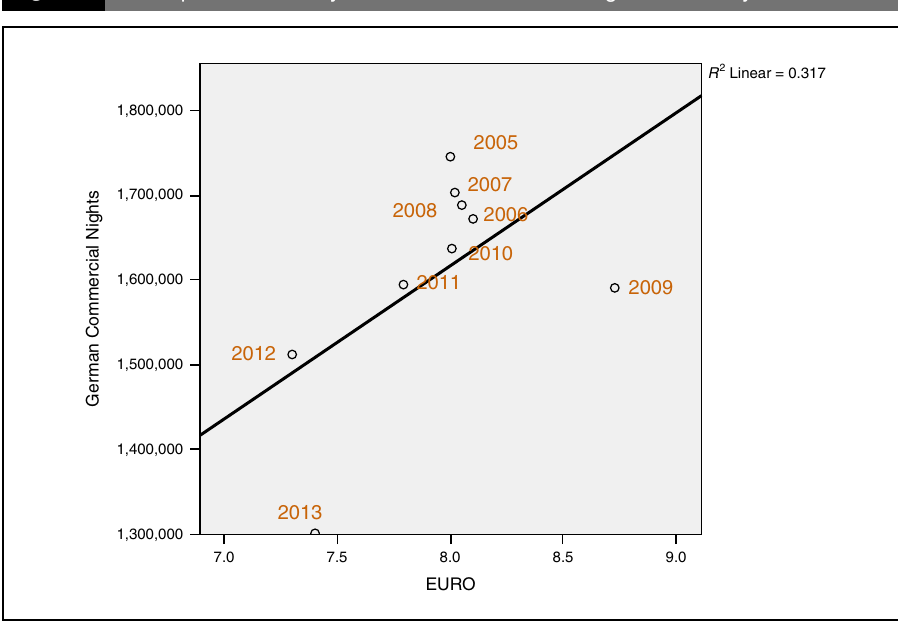
Figure 2 The impact of currency on German commercial nights in